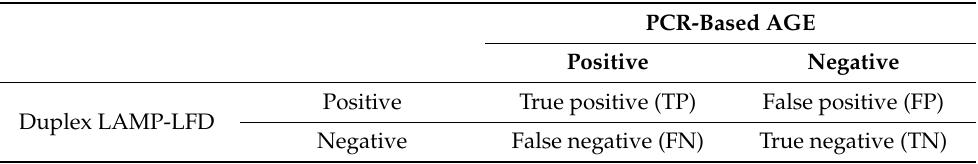
Table 2. Calculation of diagnostic sensitivity, diagnostic specificity, accuracy and coefficient of variation (CV) of duplex LAMP-LFD against conventional PCR-based AGE.